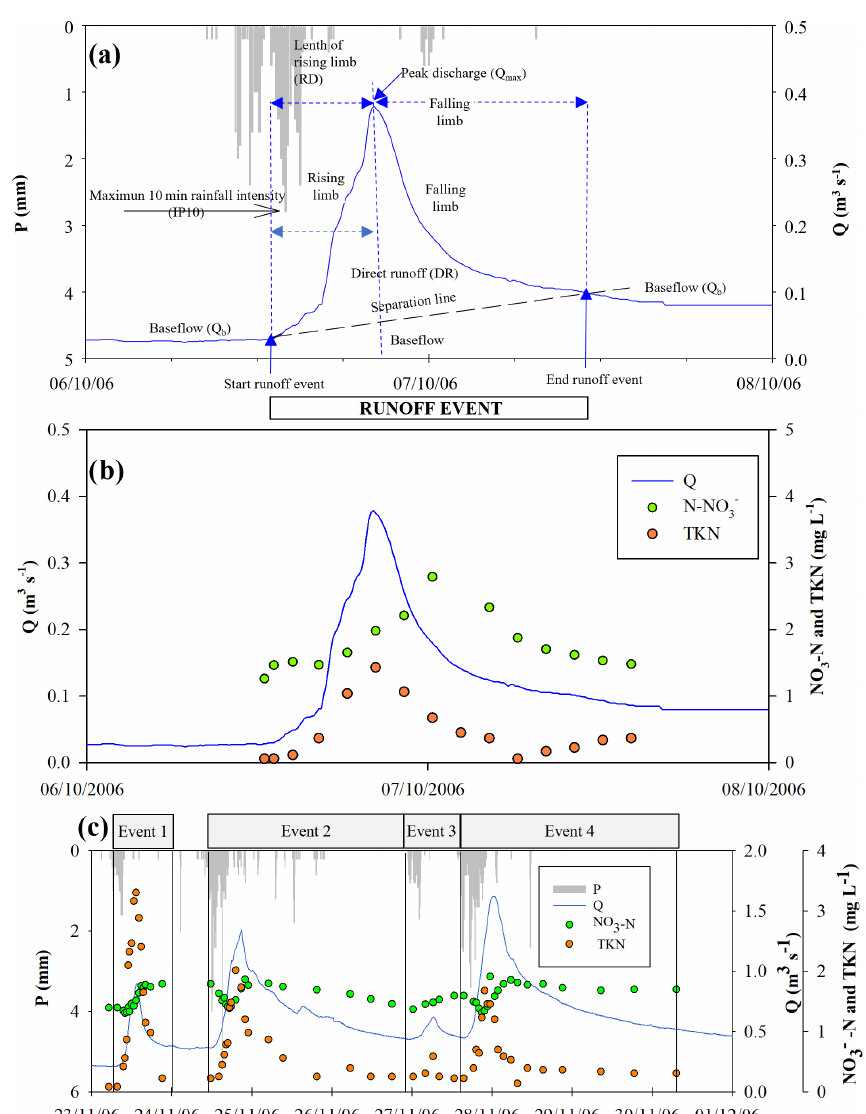
Figure 3. (a) Diagram illustrating the hydrograph separation in two components (direct runoff and baseflow), using the constant slope hydrograph separation by Hewlett and Hibbert (1967). Some variable characteristics of the rainfall–runoff events are also indicated. (b) Example of evolution of NO 3 − (NO 3 -N) and TKN concentrations during a runoff event. (c) Sequence of rainfall–runoff events and evolution of NO 3 − (NO 3 -N) and TKN